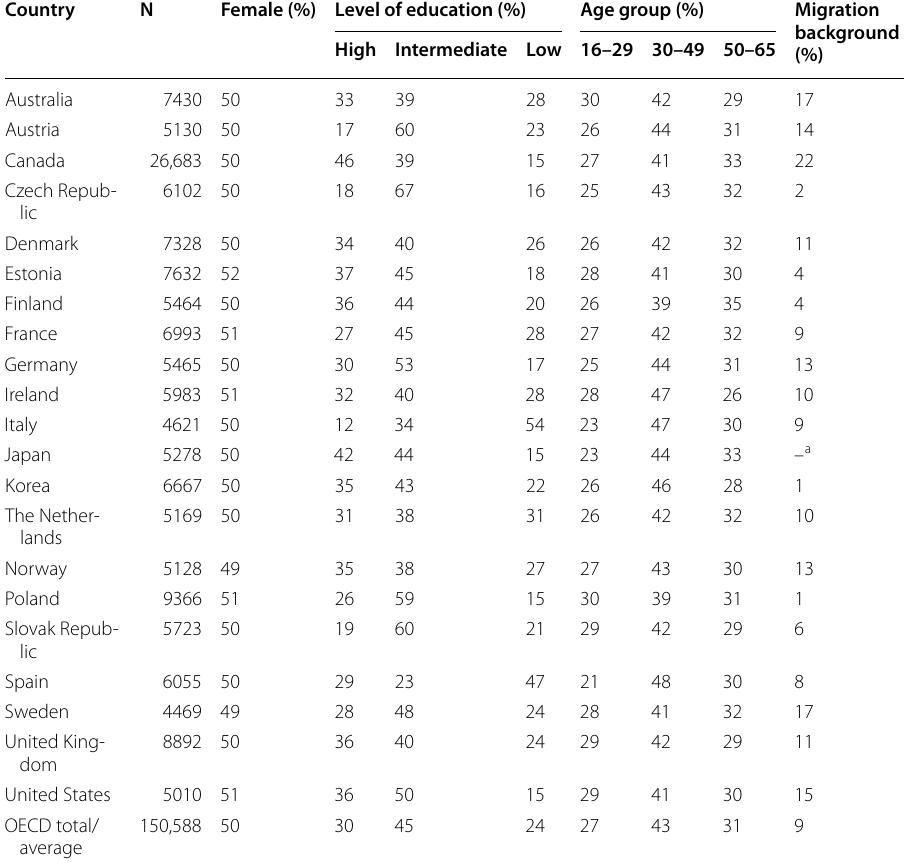
a Japan did not collect data on the migrant population